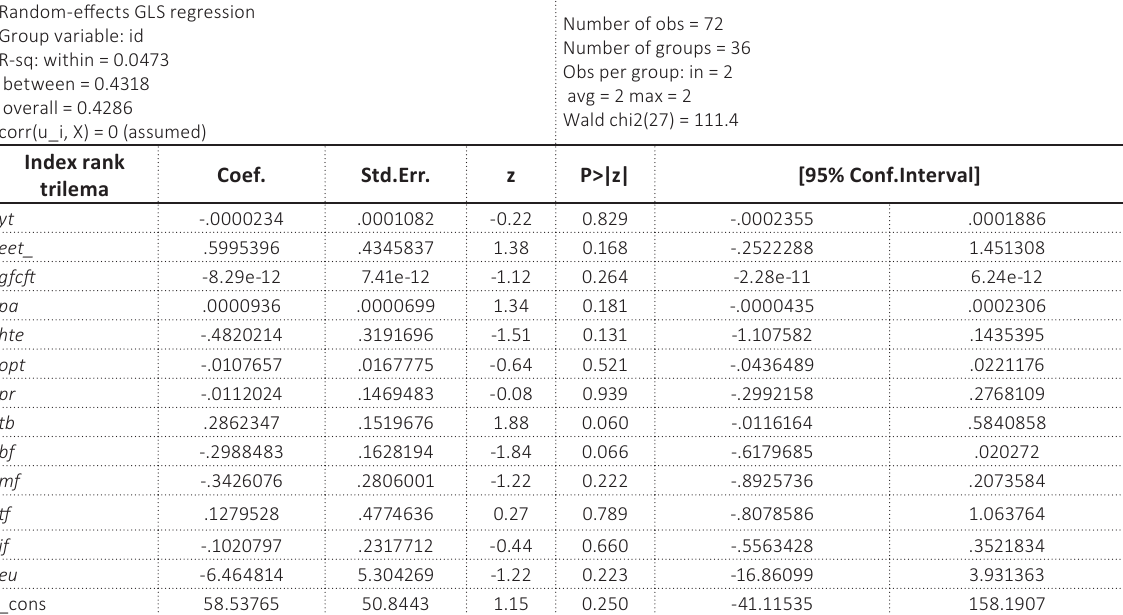
Table 2. The empirical results of economic, social, and institutional drivers’ influence on Smart Grid improvements (measured as TI) in OECD countries in 2014-2015 Random-effects GLS regression Group variable: id R-sq: within = 0.0473 between =